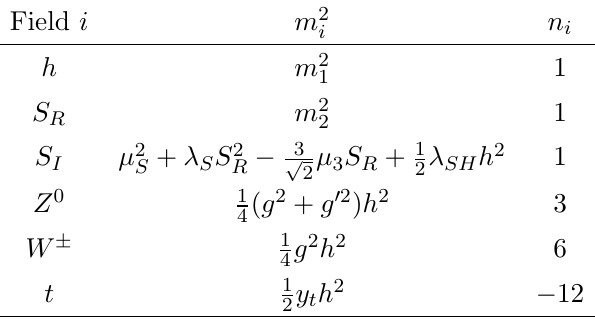
Table 1 . Field-dependent masses and degrees of